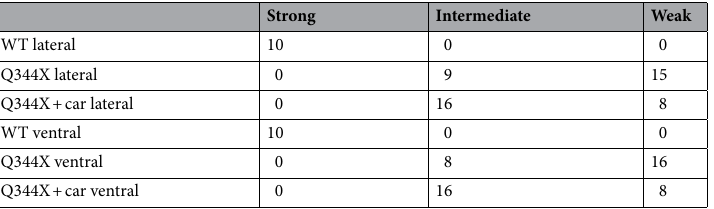
Table 2. Rod analysis on whole-mount eyes. All larvae were bleached and examined from the lateral and ventral sides. The rho:EGFP signal were classified into 3 categories by the extent of its fluorescence. The Strong group contains the samples with high rod number/signal intensity in the dorsal retina and ventral patch; the Intermediate group contains the samples with distinct rods in the dorsal retina with noticeable gaps, and some rods in the ventral patch extending medially; and the Weak group contains the samples with sparse rods in the dorsal retina and the most lateral edge of the ventral patch. The WT image in Fig. 3e. is representative of the “Strong” group, the Q344X image in Fig. 3e. is representative of the “Weak” group, and the Q344X + car in Fig. 3e. is representative of the “Intermediate” group. Carvedilol treatment increased the number of Q344X larvae with Intermediate phenotypes and reduced the number of Weak phenotypes in both the lateral (Chi- 2 2 square test, χ = 4.09, df = 1, p value < 0.05) and ventral views (Chi-square test, χ = 5.33, df = 1, p value < 0.05). No Q344X larvae was classified as Strong with or without carvedilol treatment.